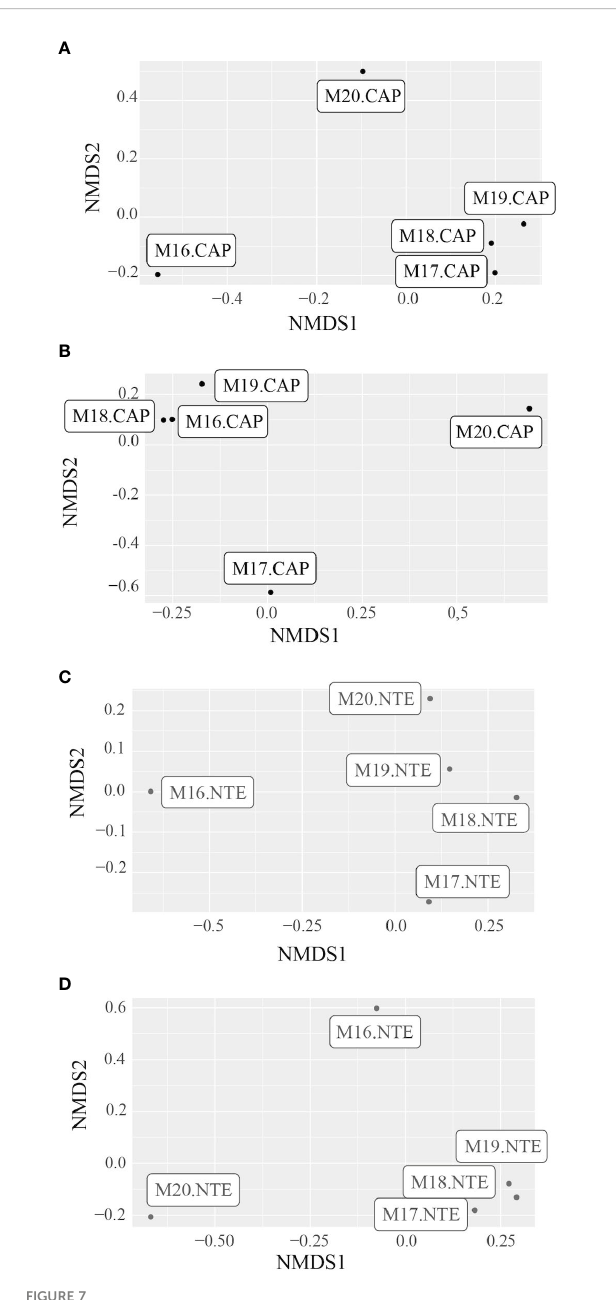
FIGURE 7 NMDS plot representing the differences between the bacterial communities ’ structure of the fi ve samples from (A) Capelinhos (black) and (C) North Tour Eiffel (grey), and between the archaeal communities ’ structure of the fi ve samples from (B) Capelinhos (black) and (D) North Tour Eiffel